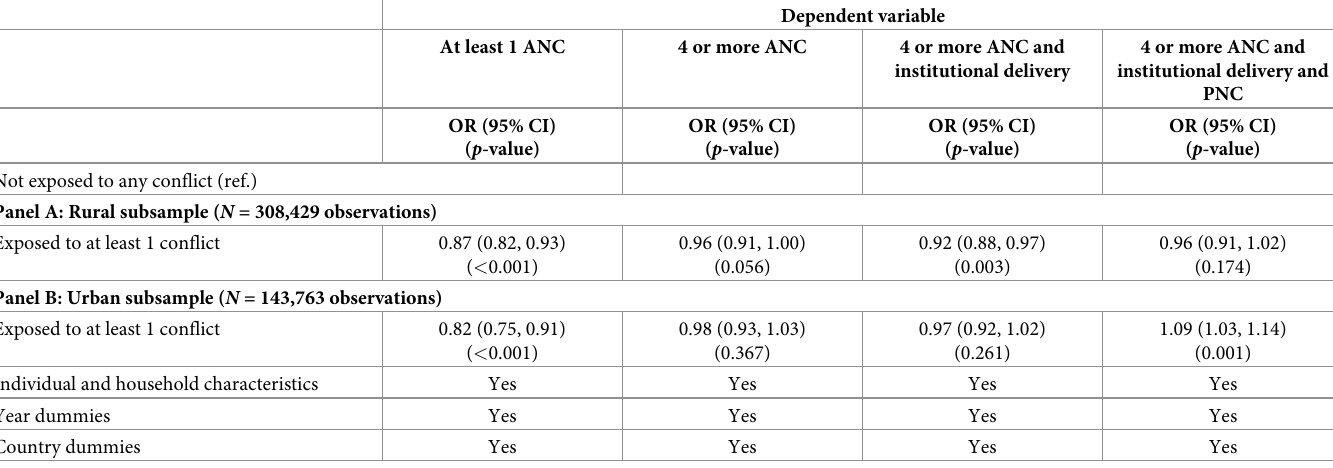
Table 4. Associations between exposure to conflict and CoC for rural and urban subsamples.